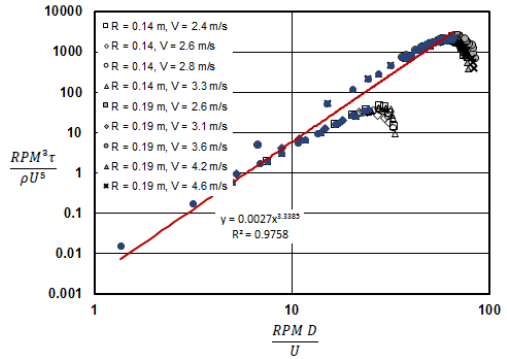
Figure 8. Torque measurement results of the rotor with a radius of 0.19 m.